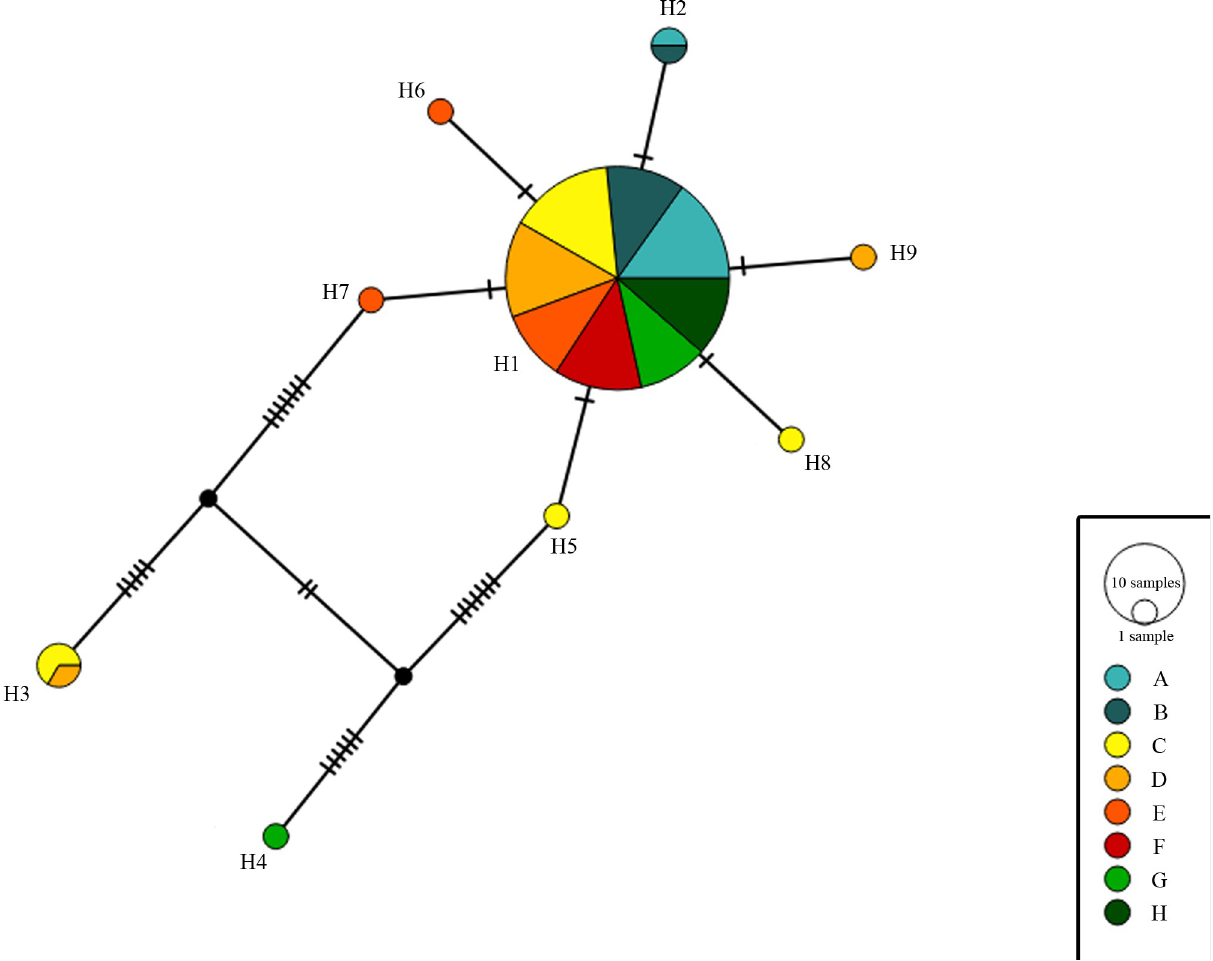
Fig 2. Median-joining network displaying the mtDNA control region variation of L . maximus in Argentina. Haplotypes are represented with discs and colors that indicate geographical locations. Mutational steps are indicated with stripes. A-H corresponds to the defined groups in this study (see Fig